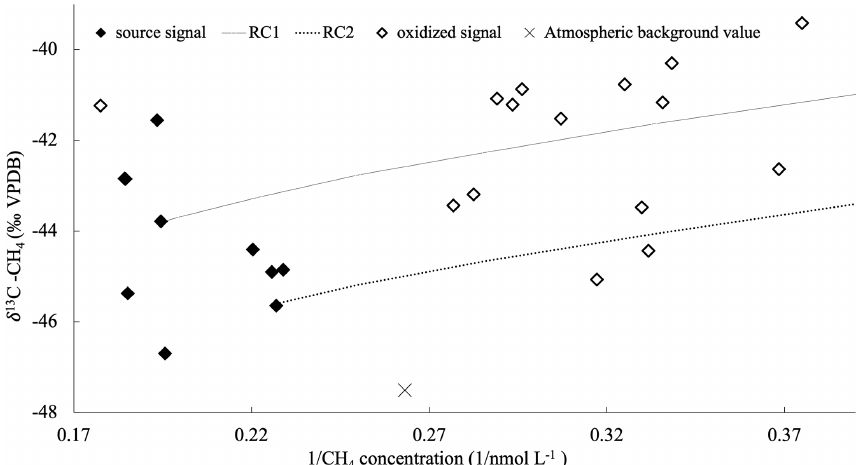
Figure 6. The reciprocal of methane concentration vs. the δ 13 C-CH 4 in sea ice. Methane enclosed in impermeable layers (black diamonds) deviates from the atmospheric background value (cross) and reflects the initial methane (source) signal being unchanged and stored in impermeable sea ice during the drift. The source signal also represents the starting point for the calculation of potential methane consumption. The residual methane (open diamonds), i.e., a pool with less methane concentration but more enriched in 13 C, is formed by methane consumption in a permeable layer enclosed by impermeable ice layers in ridged/rafted ice. Two Rayleigh curves (RC1: dashed line; RC2: dotted line) have been calculated with two different initial isotopic signatures ( − 44‰VPDB and − 46‰VPDB), respectively; α is 1.004 (see Sect. 4.1.1 and